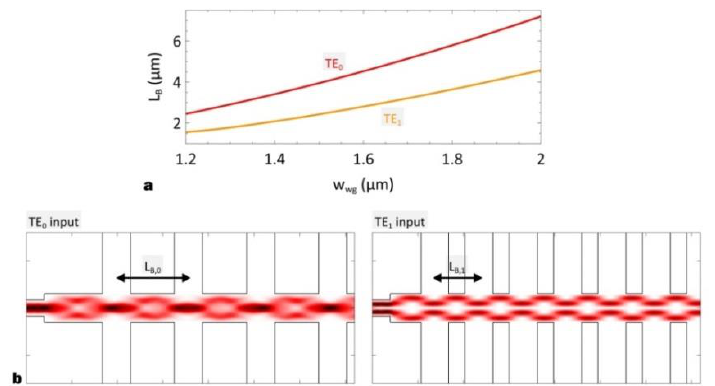
Figure 14. ( a ) The calculated beat lengths (L B ) for TE 0 and TE 1 modes with varied waveguide width (w wg ). ( b ) The calculated light propagation profiles for MMI-based crossings when TE 0 (left panel) and TE 1 (right panel) are launched. The beat lengths are different between TE 0 and TE 1 .